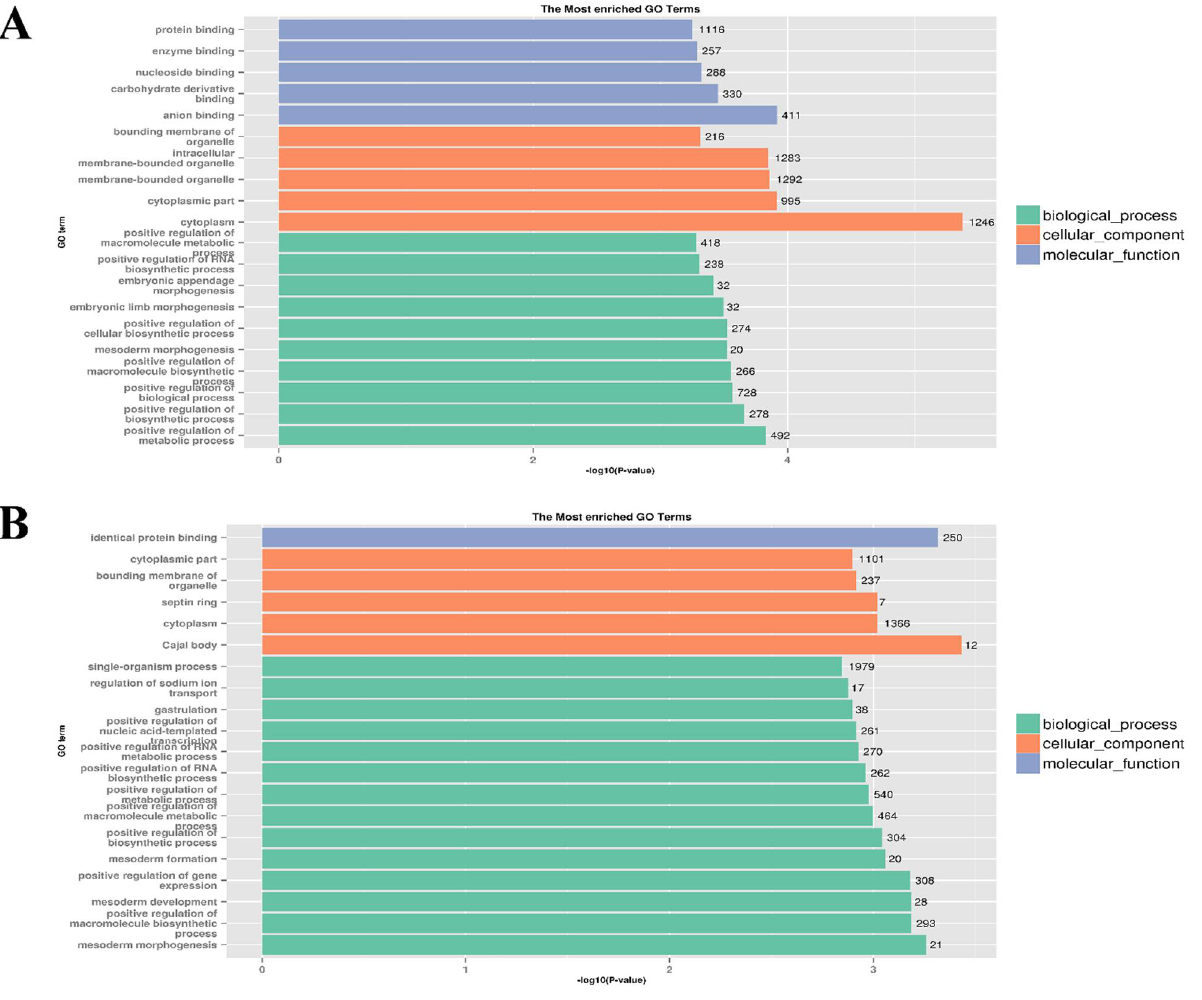
Figure 5. The top 20 GO terms of predicted target genes. ( A ) The top 20 GO terms in F14 vs. F20 comparison group; ( B ) the top 20 GO terms in S14 vs. S20 comparison group.